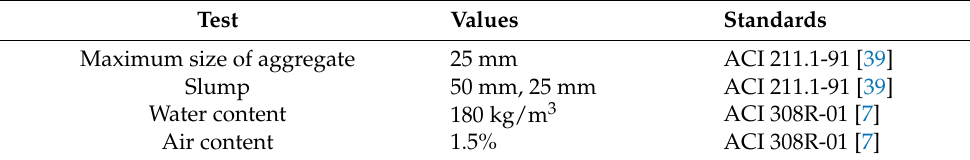
Table 4. Material Selection for Mix Design.